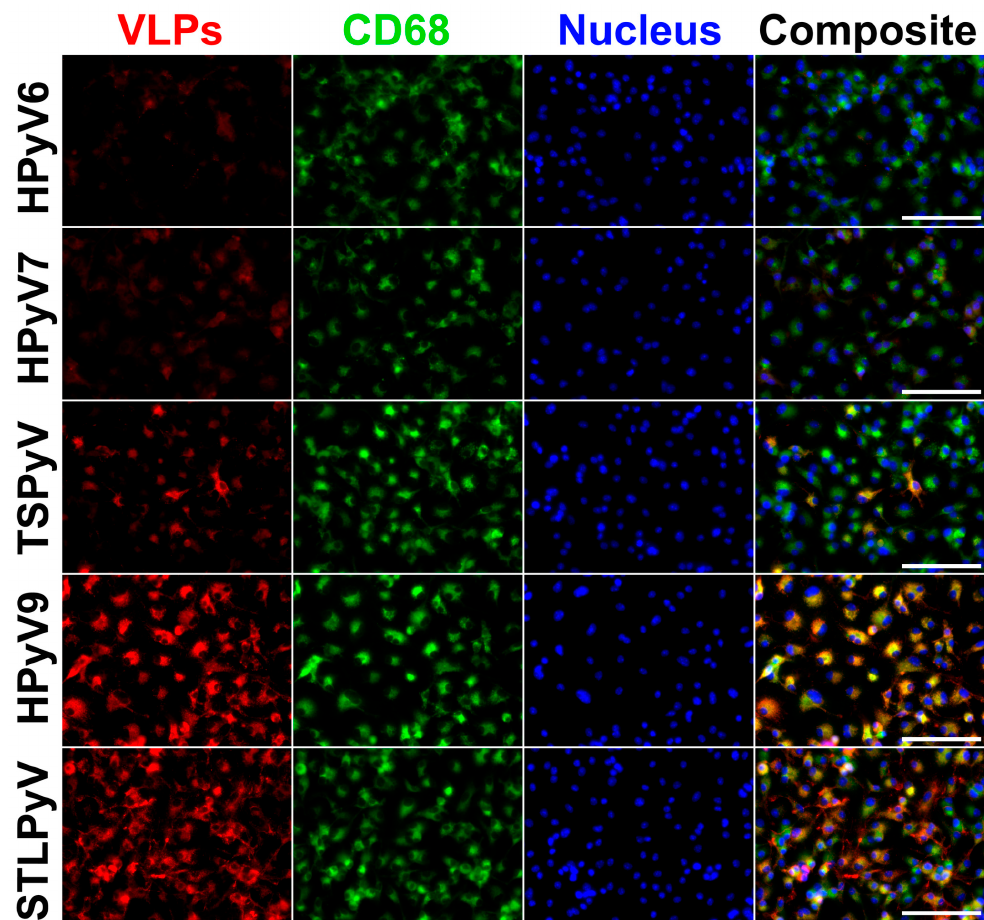
Figure 4. The uptake of VP1 VLPs of different HPyVs by primary mouse macrophages. Macrophages were treated with VP1 VLPs for 24 h at 20 μ g/mL concentration. Cells were immunostained with VP1 VLP-specific MAbs (red), anti-CD68—macrophage and lysosomal marker (green), nuclear stain Hoechst33342 (blue) and analysed by fluorescence microscopy. The experiment was repeated twice, and representative images of one experiment are shown. Secondary antibody control is referred to as control. Images were taken using ×40 objective. The scale bars indicate 100 μ m.